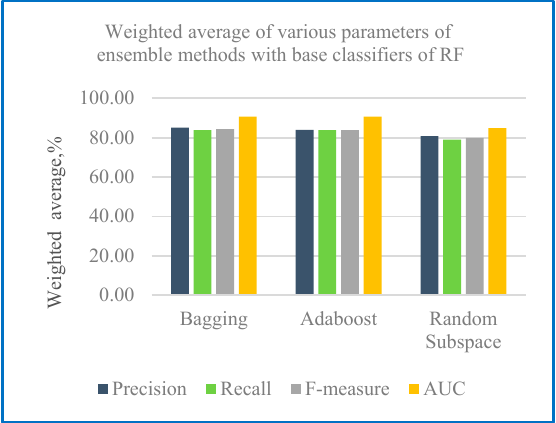
Figure 16. Weighted average of various parameters of ensemble methods with base classifiers of RF.